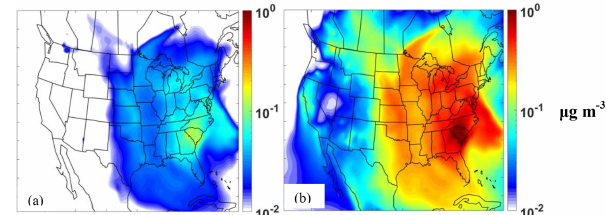
Figure 9. PMCAMx-SR-predicted ground-level concentrations (µgm − 3 ) of bbSOA-iv for the base scheme using (a) the base case volatility distribution and (b) the Ciarelli et al. (2017a, b) volatility